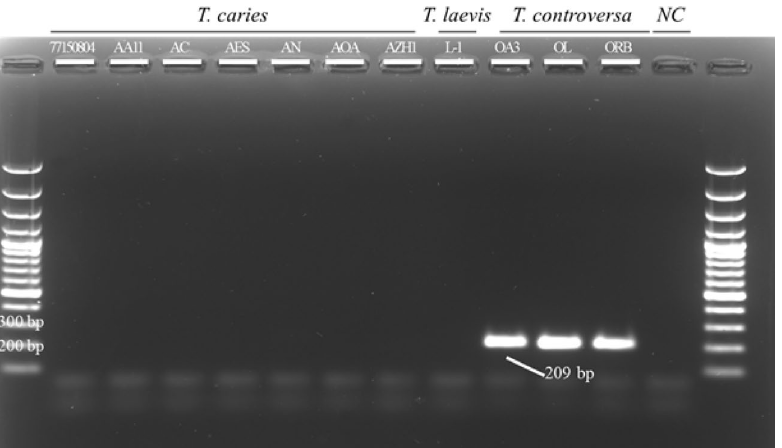
Figure 3. Polymerase chain reaction (PCR) using the outer LAMP primers to amplify the DNA region used for LAMP assay development. PCR products were separated on a 2% agarose gel and visualized using SYBR Safe gel staining. Ladder is a 100 bp Plus GeneRuler and NC is negative control. No amplicon was produced in the absence of T. controversa DNA.